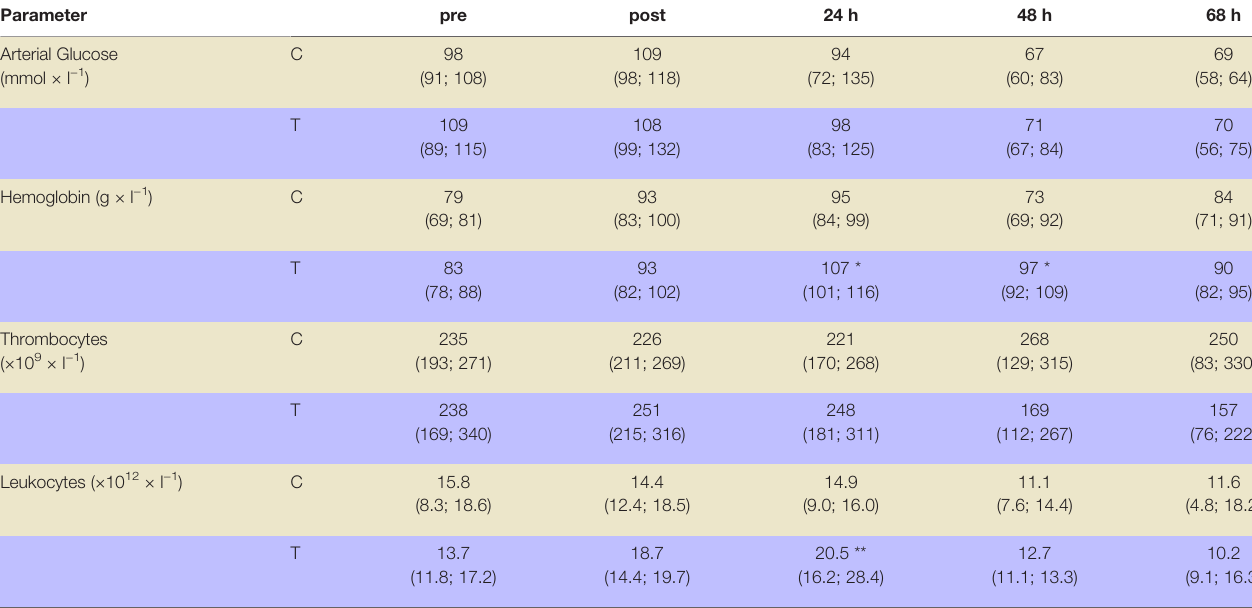
TABLE 2 | Blood glucose, hemoglobin, thrombocyte and leukocyte cell count before (pre) and after 3 h of hemorrhagic shock (post) as well as 24 h, 48 h, and 68 h after resuscitation.